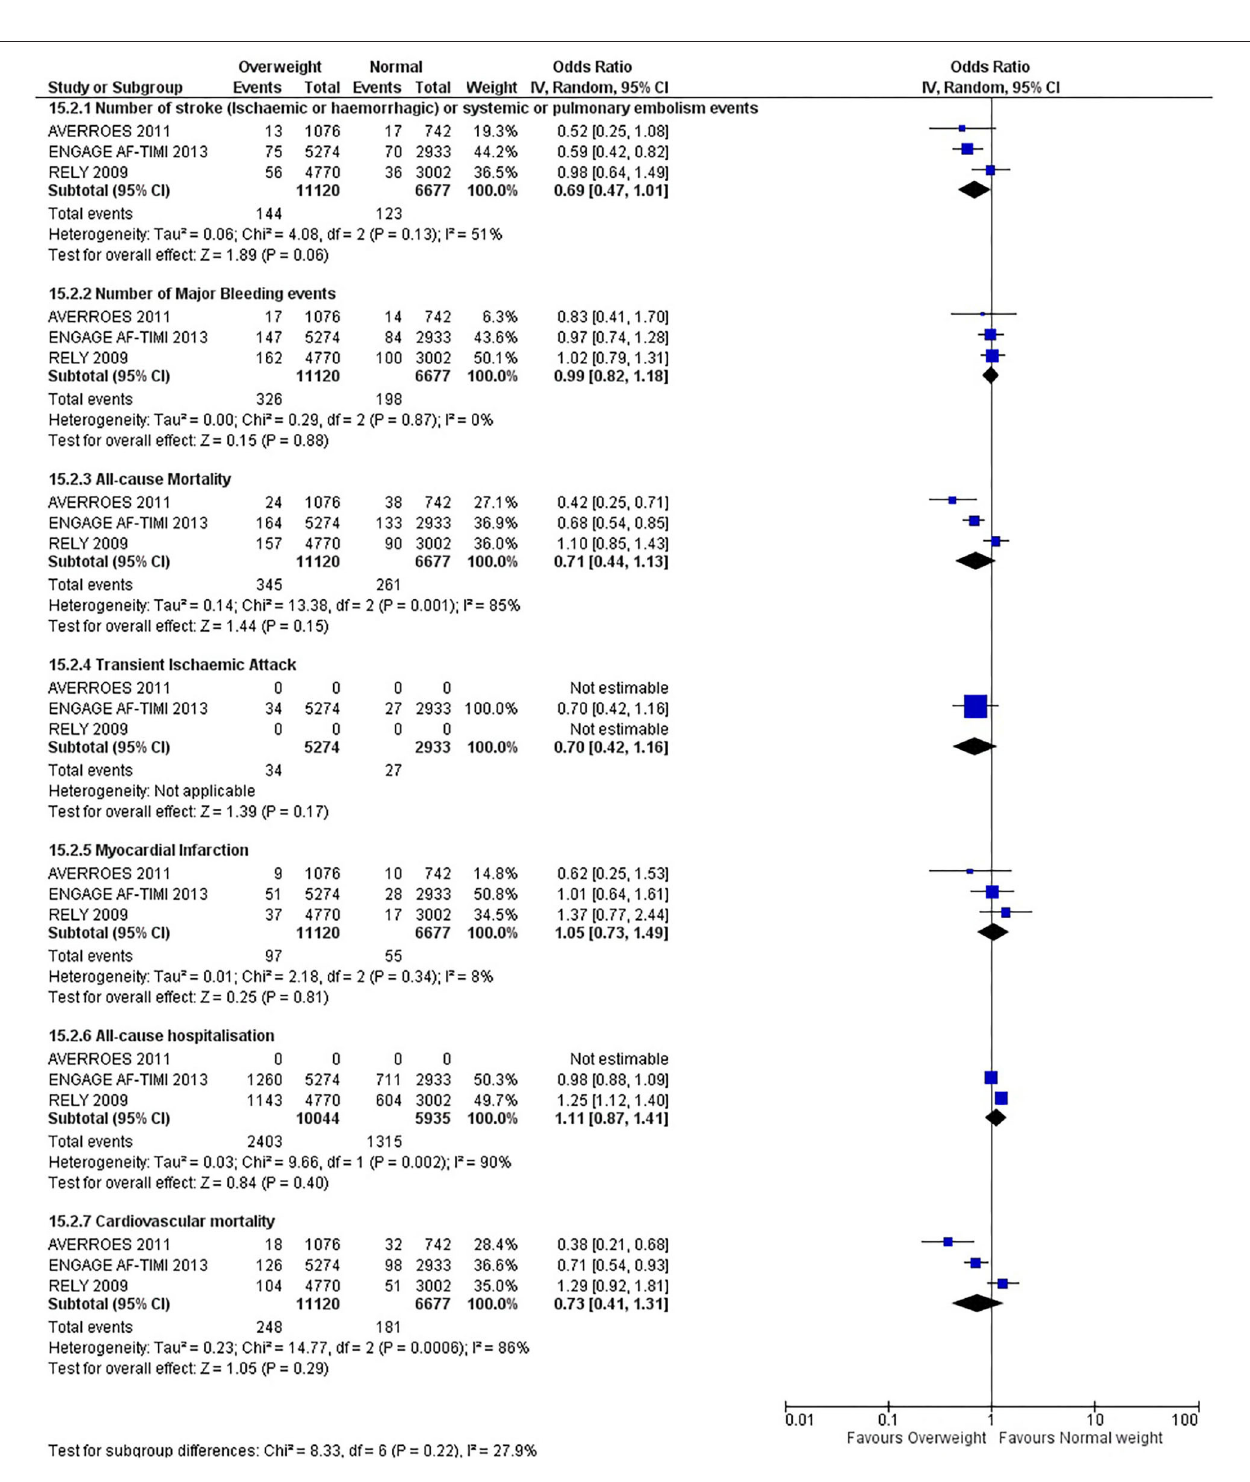
FIGURE 4 | Forest plot of comparison: Normal vs. Overweight at 12 months.